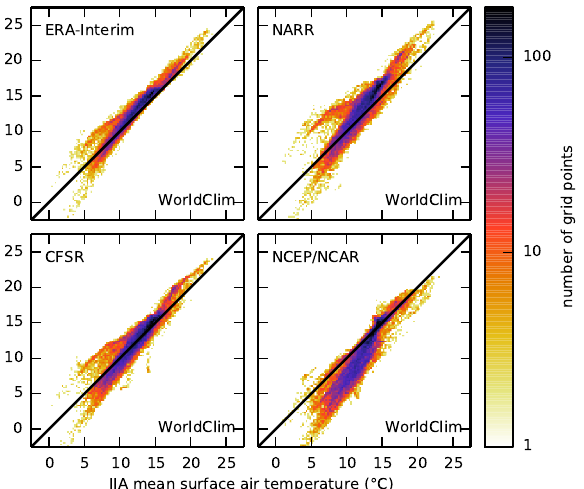
Figure 8. Density maps showing a comparison of summer (JJA) sur- face air temperature data from the WorldClim climatology, against that of each reanalysis. Climate data are presented after bilinear spatial interpolation and correction for topographic differences to WorldClim data, using a lapse rate of 6 ◦ Ckm − 1 . Colour mapping is based on a logarithmic scale. Note the cold bias of NCEP/NCAR data relative to WorldClim data.